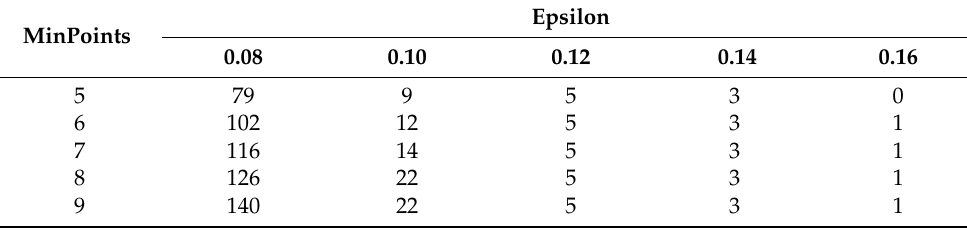
Table 3. Number of potential novelties based on several Epsilon and MinPoints